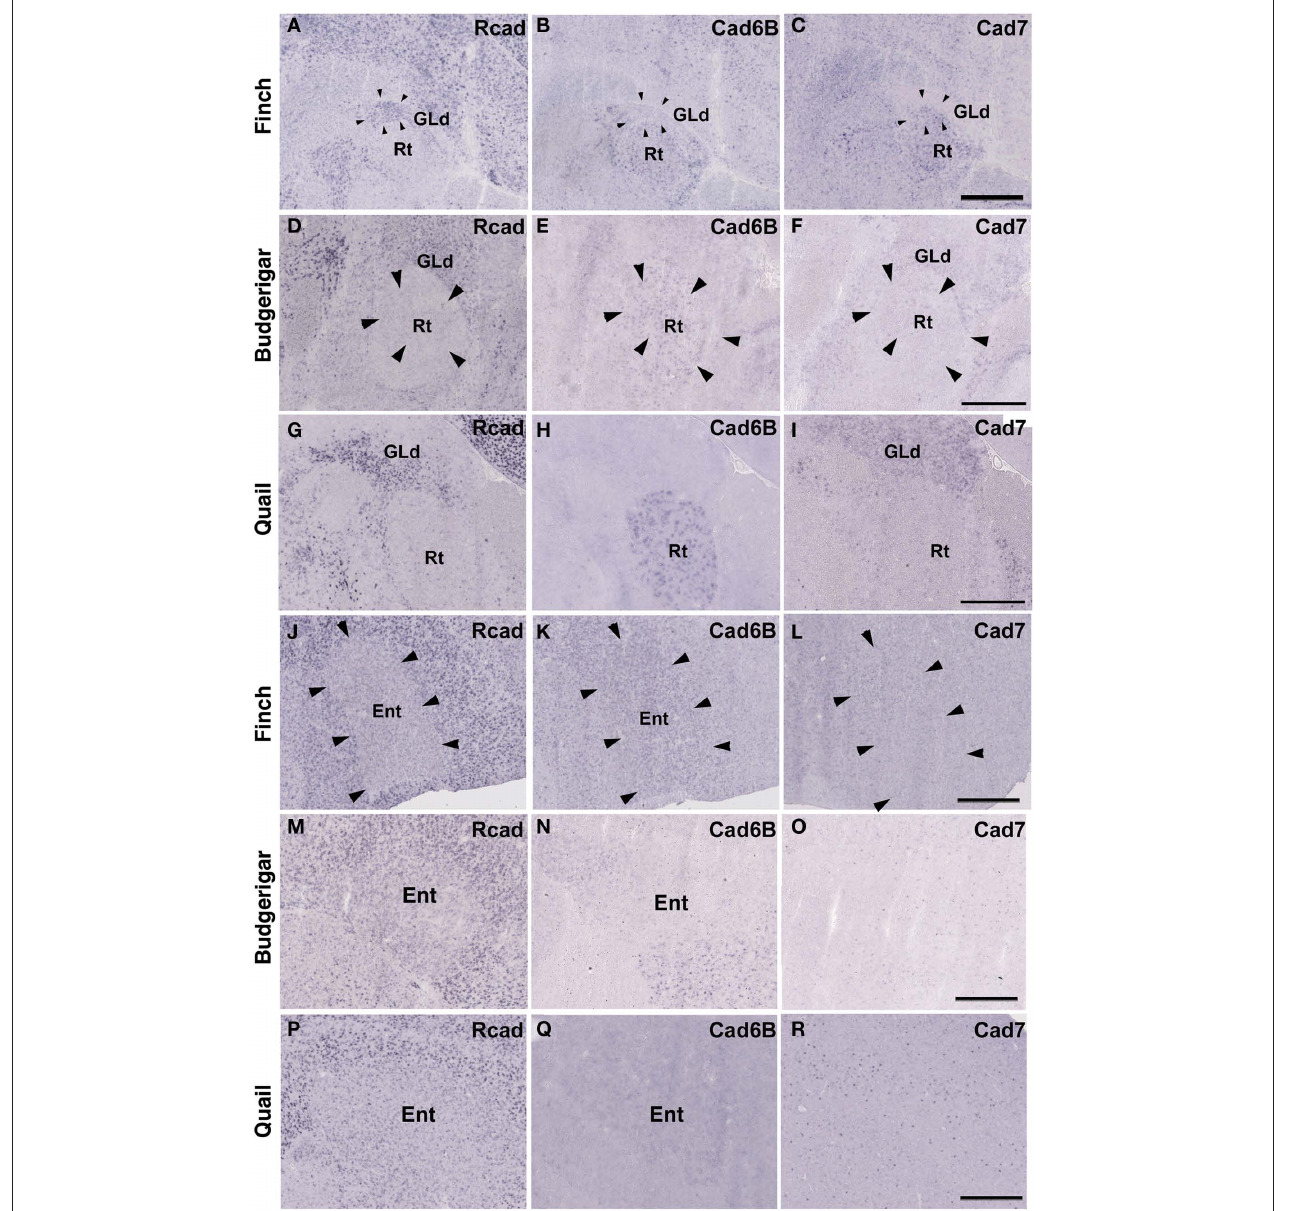
Figure 6 | Cadherin expression in the visual system at the level of the thalamus and telencephlon. (A–i) In situ hybridization for Rcad (A,D,g) , cad6B (B,e,H) , and cad7 (C,F,i) in the Bengalese finch (A–C) , budgerigar (D–F) , and